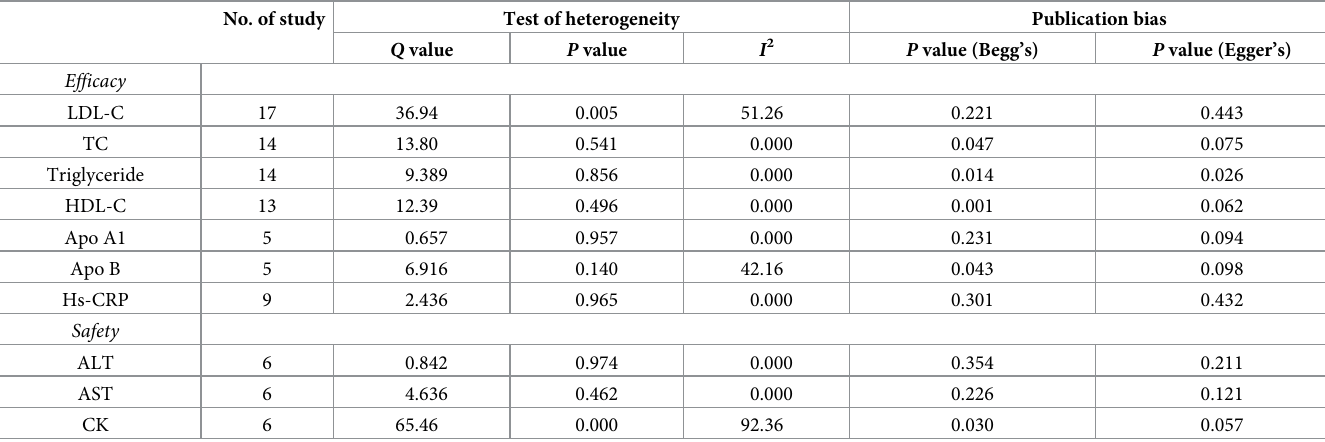
Table 2. Test of heterogeneity and publication